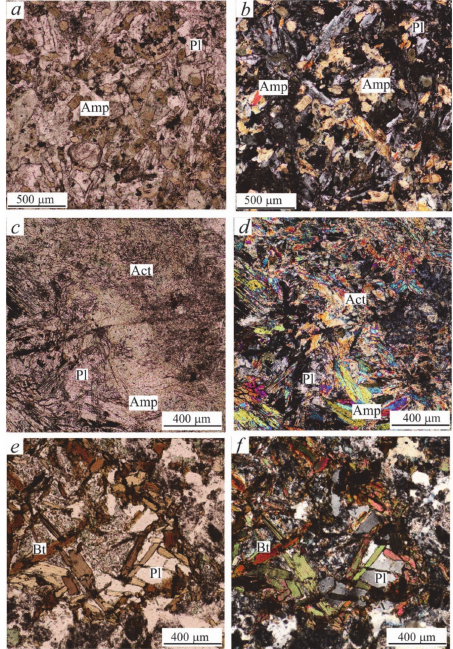
Figure 7. Photomicrographs in cross- and plane-polarized light of the metavolcanic rocks: ( a , b ) Basalt’s fine-grained structure with hypidiomorphic aphanitic texture of groundmass consisting of amphibolitized pyroxene and laths of subidiomorphic plagioclase; ( c , d ) fine-grained andesitic basalt with subophitic textures consisting of fibrous amphibole (tremolite-actinolite), and sassuritized aggregate of plagioclase; and ( e , f ) fine-grained andesite with a microporphyritic texture consisting of plagioclase-biotite groundmass with an aphanite texture. Abbreviations: